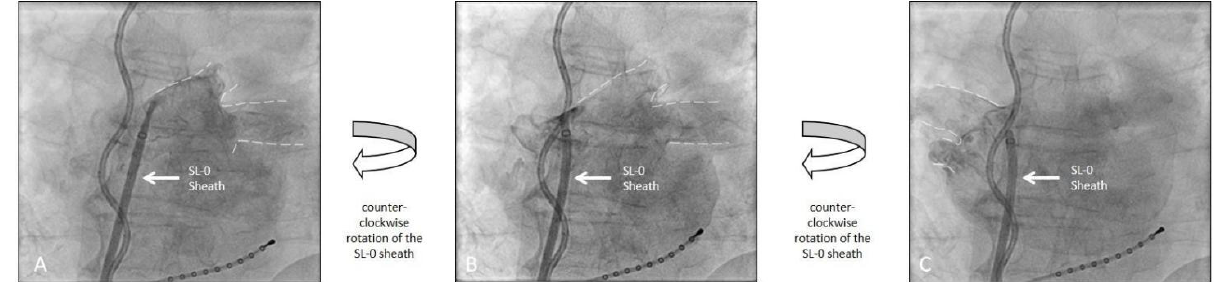
Figure 1. Left atrial angiography demonstrating the visualization of the pulmonary veins and con- tour of the left atrium with a single injection of contrast medium. ( A ): initial injection of contrast dye for the left pumonary veins (dotted lines). ( B ): Continuation of the initial injection of contrast dye with a counter-clockwise rotation of the SL-0 Sheath further appreciating the anatomy of the left pulmonary veins (dotted lines). ( C ): Continuation of the initial injection of contrast dye with an ad- ditional counter-clockwise rotation now visualizing the right pulmonary veins (dotted lines). The fluoroscopic images were recorded in an anterior-posterior projection (AP). (Also see Supplemen- tary Material).